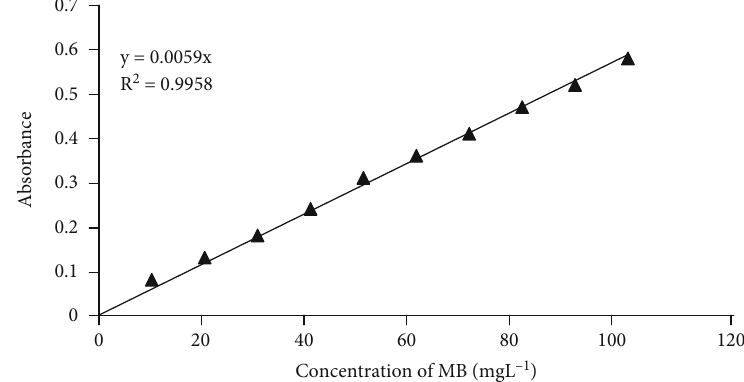
Figure 2: Calibration curve for methylene